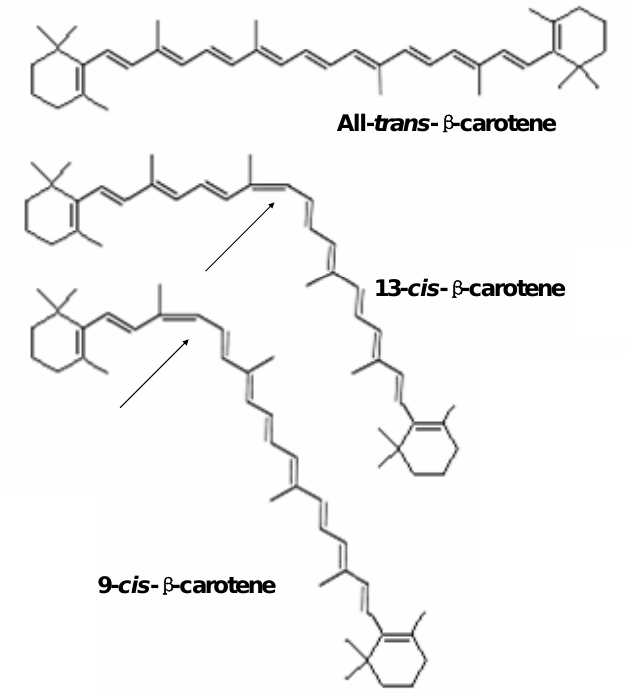
Figure 1. The structure of all- trans - β -carotene and its two geometric isomers